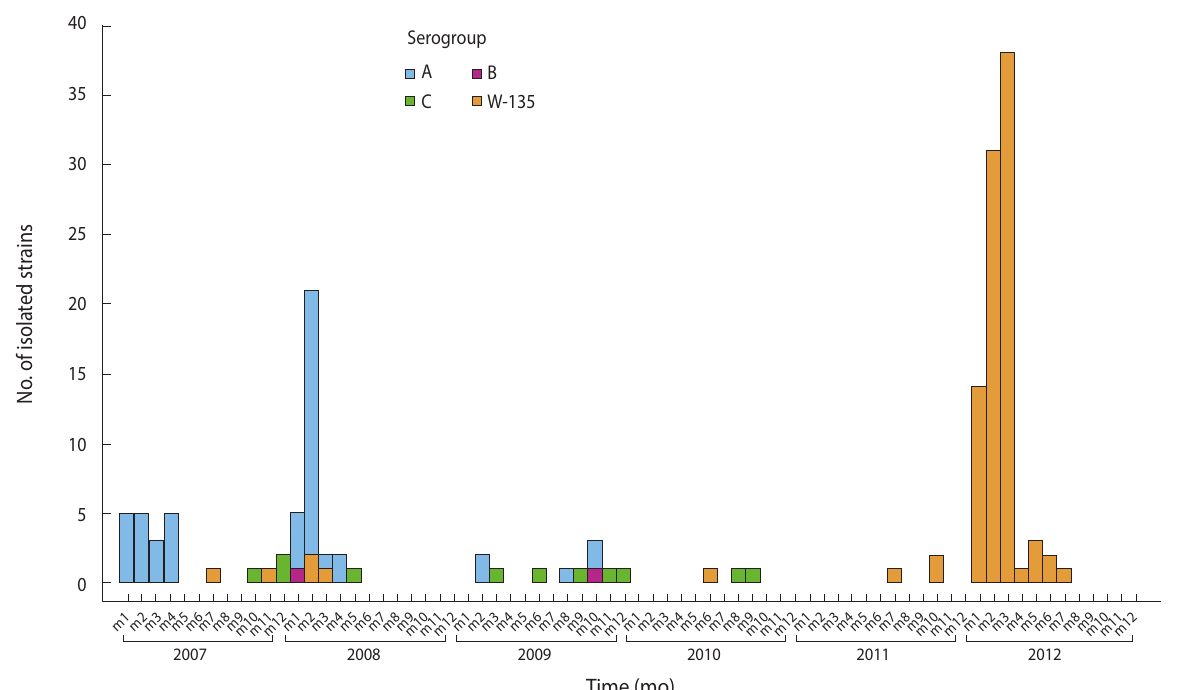
Figure 1. Trends in the frequency of meningococcal strains isolated at the National Reference Center for meningitis from 2007 to 2012 by serogroup, Cote